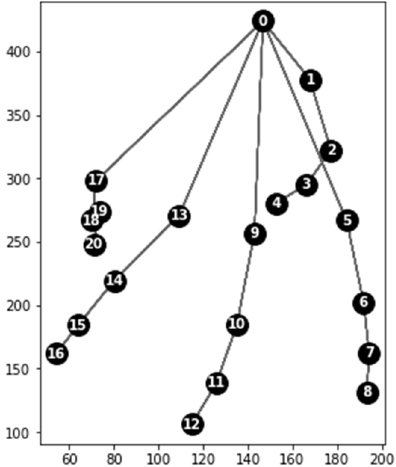
Figure 6. Visualization of hand points.